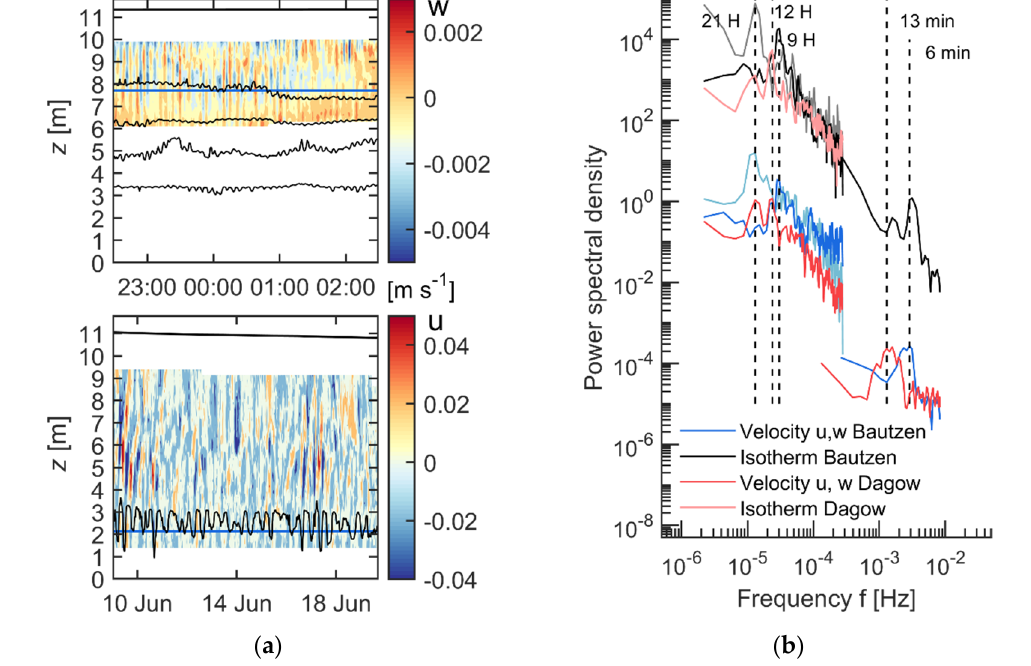
Figure 5. ( a ) Sample data from Bautzen Reservoir illustrating high-frequency internal waves with a period of 6 min (upper panel) and basin-scale internal waves with the period of 9 h (lower panel). The upper and lower panels show vertical ( w ) and horizontal ( u ) velocity components, respectively. Black lines show temperature isotherms; blue lines show the distance above the bed for which the velocity power spectra are shown in panel ( b ). ( b ) Power spectral density estimates for flow velocity components (m 2 s − 1 ) and isotherms (m 2 s). Blue, light blue and red solid lines show velocity spectra; gray, black and light red show isotherm spectra for Bautzen Reservoir and Lake Dagow, respectively. Internal waves are associated with distinct spectral peaks and vertical dashed lines denote major internal wave periods.